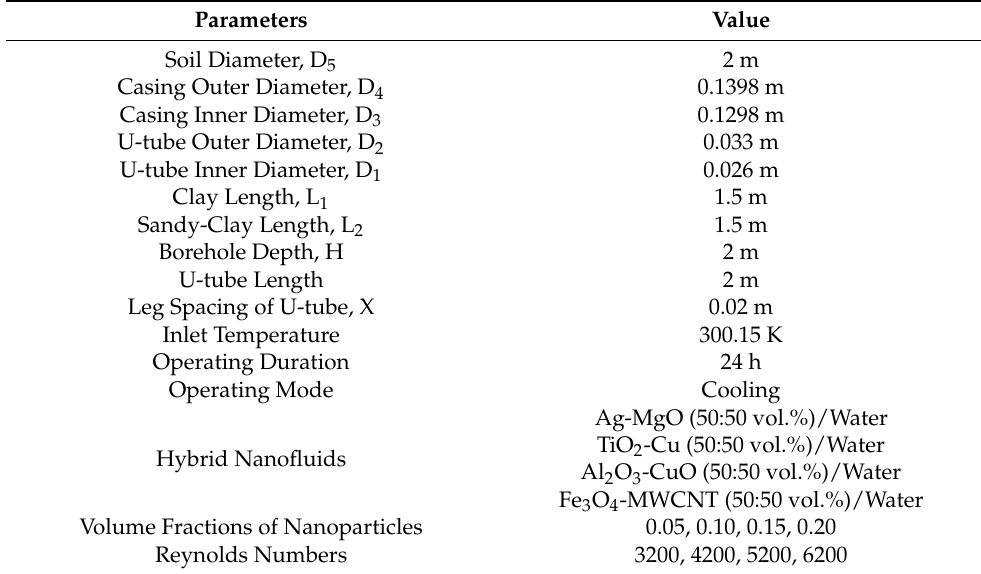
Figure 1. Schematic of the borehole heat exchanger (BHE): ( a ) 3D view, and ( b ) 2D view (ground surface). Table 1. Geometric and operating parameters and studied